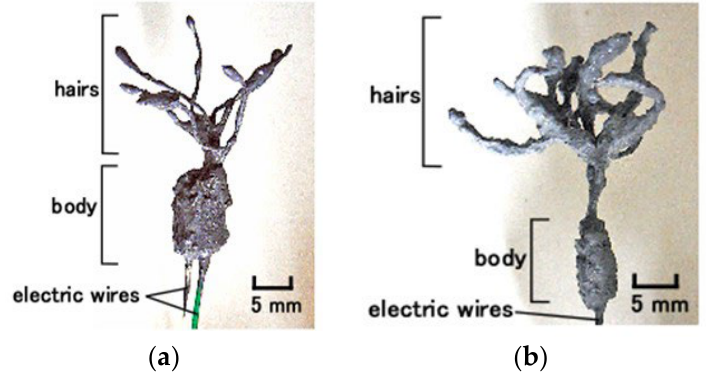
Figure 2. Images of the designed cutaneous receptor fabric produced using electrolytic polymerization of HF rubber: ( a ) free nerve endings and ( b ) Pacinian corpuscles.